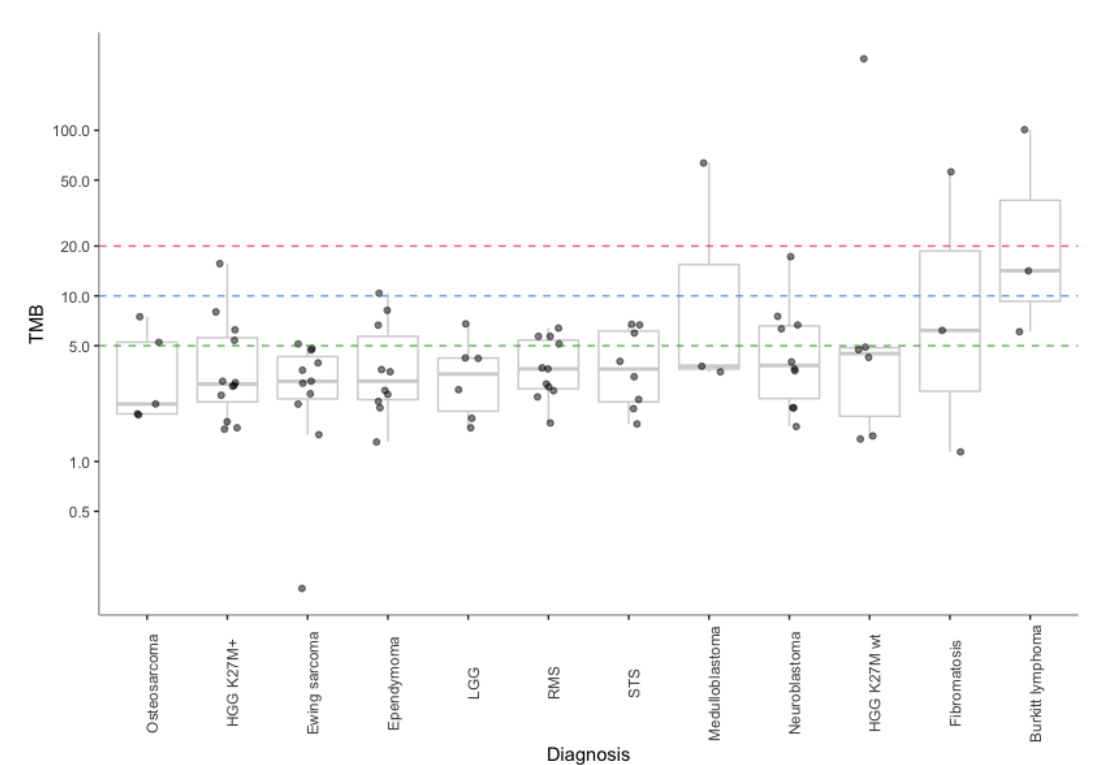
Figure 1. Tumor mutational burden (TMB) values determined in our pediatric cancer patient cohort (WES—Method1) stratified by cancer type. Hypothetical TMB cut-o ff values are shown as dashed lines (green, TMB ≥ 5; blue, TMB ≥ 10, red, TMB ≥